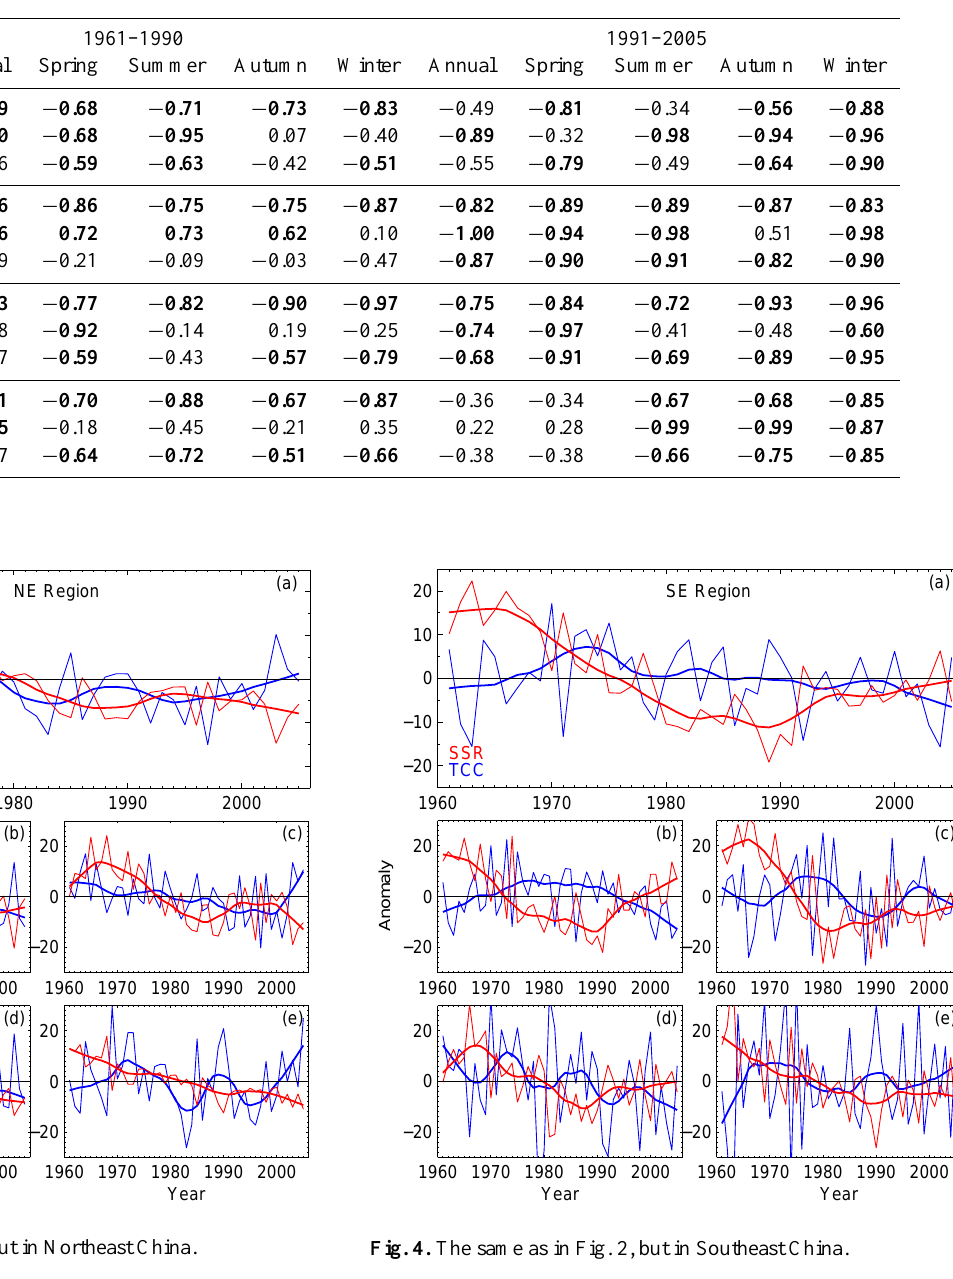
Table 2. Correlation coefficients between annual and seasonal time series of surface solar radiation and total cloud cover. “Raw” denotes coefficients for the original anomalies time series; “High” denotes the remaining high-frequency, inter-annual variations after detrending with the Lowess algorithm; and “High” denotes the correlations of the low-frequency part of the original time series as derived from Lowess. Coefficients given in bold are significant at the 95% level.